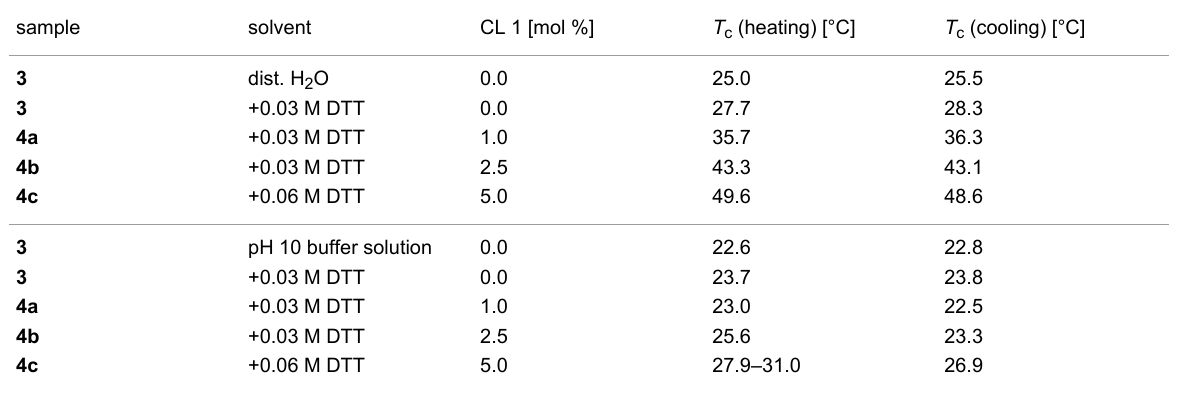
Table 4: Cloud point temperatures T c of poly(DEAAm- co -DMAEMA) bearing thiole side chains after disulfide cleavage with DTT in dist. H 2 O and pH 10 buffer solution.